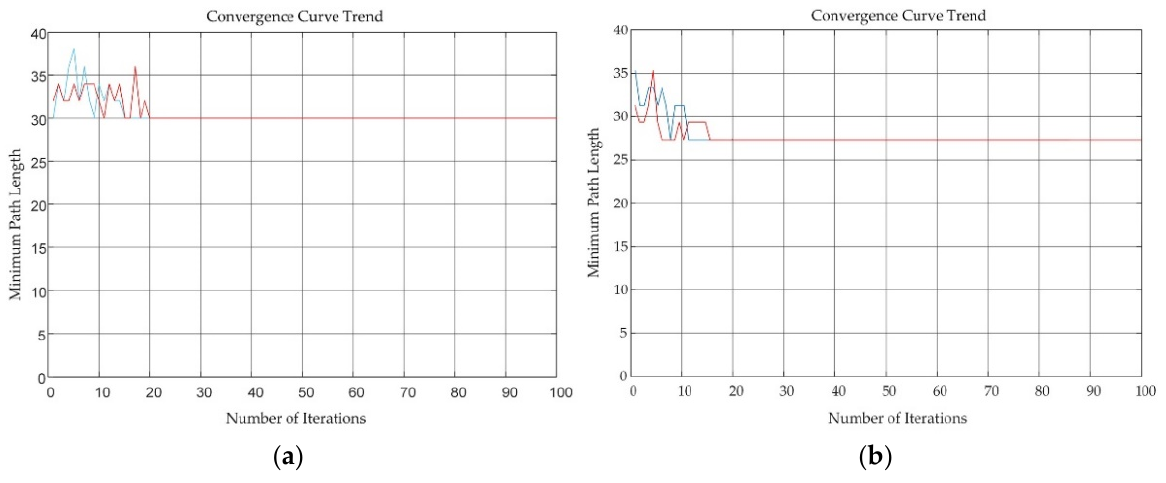
Figure 14. Schematic diagram of the convergence curve change of the ant colony algorithm (Environment 2). ( a ) Ant colony algorithm ( b ) Improved ant colony algorithm.